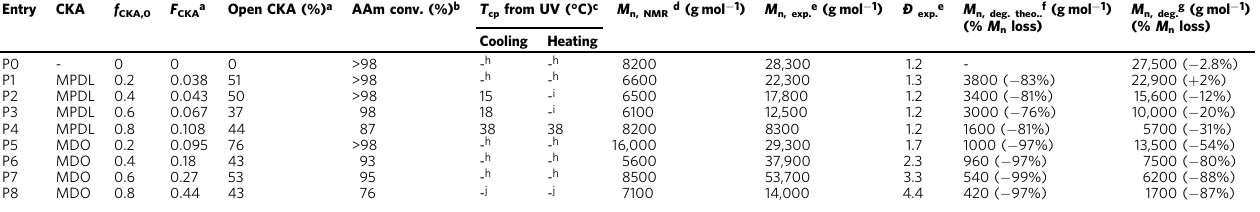
Fig. 2 Synthesis of poly(acrylamide- co -cyclic ketene acetal) (P(AAm- co -CKA)) copolymers. RAFT-mediated copolymerization between acrylamide (AAm) and cyclic ketene acetals (CKA), such as 2-methylene-4-phenyl-1,3-dioxolane (MPDL), 5,6-benzo-2-methylene-1,3-dioxepane (BMDO) and 2-methylene-1,3-dioxepane (MDO). Table 1 Experimental conditions and macromolecular characteristics of P(AAm- co -MPDL) and P(AAm- co -MDO) copolymers synthesized by RAFT-mediated copolymerization of AAm and MPDL (or MDO) in anhydrous DMSO at 70 °C for 16 h. Entry